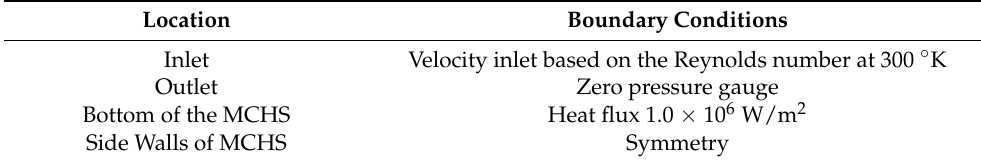
Table 3. Boundary Conditions.